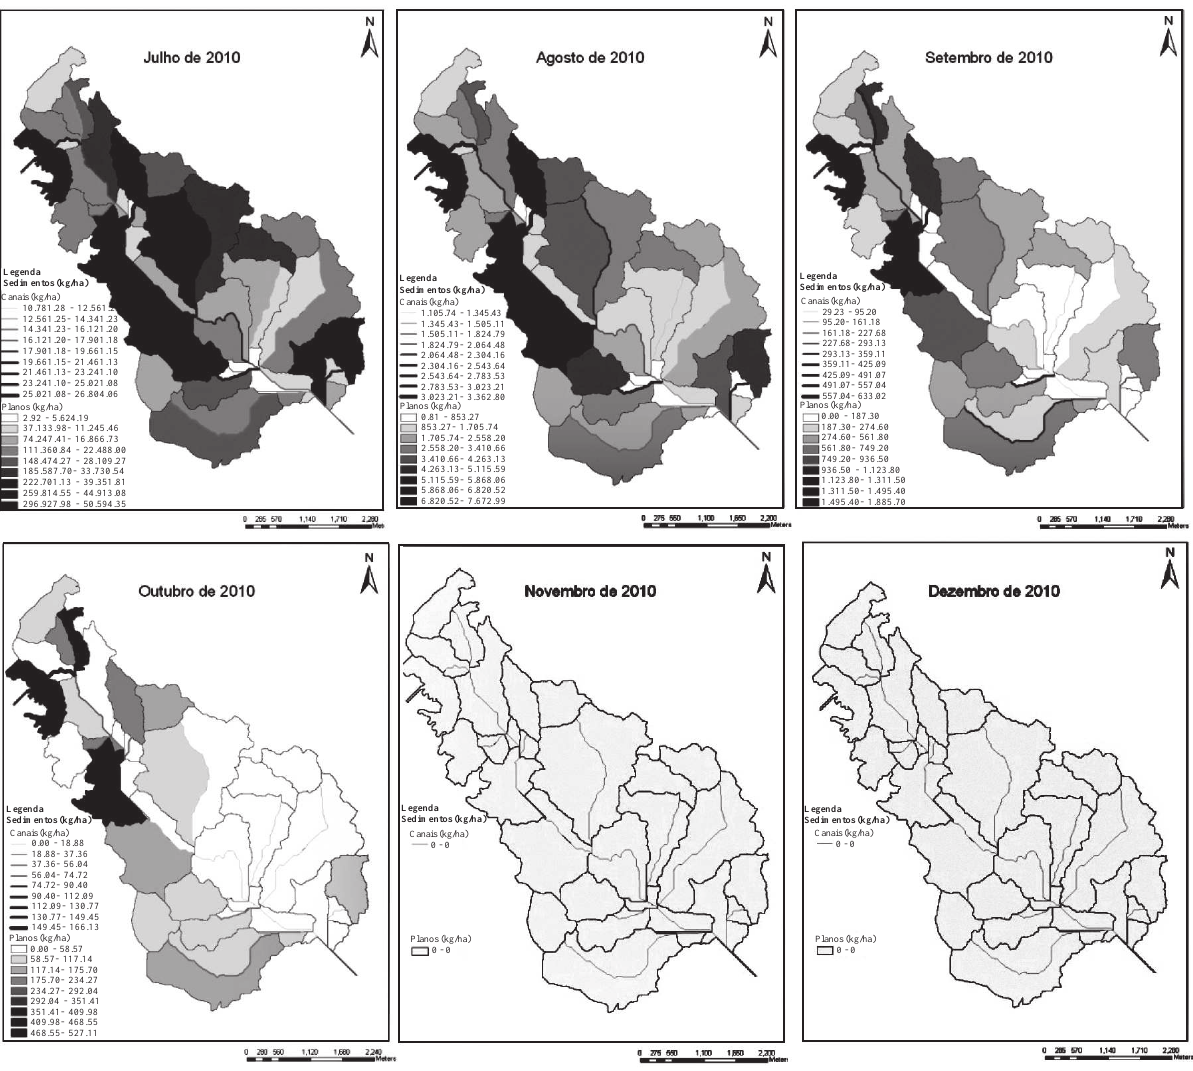
Figura 4. Espacialização da produção média calculada de sedimentos para a bacia do rio Jacarecica, de julho a dezembro de